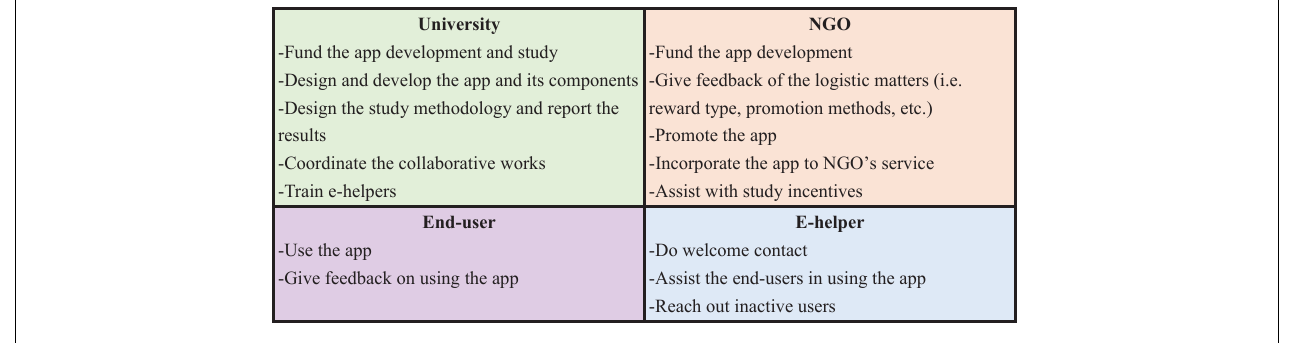
FIGURE 1 | Stakeholder members’